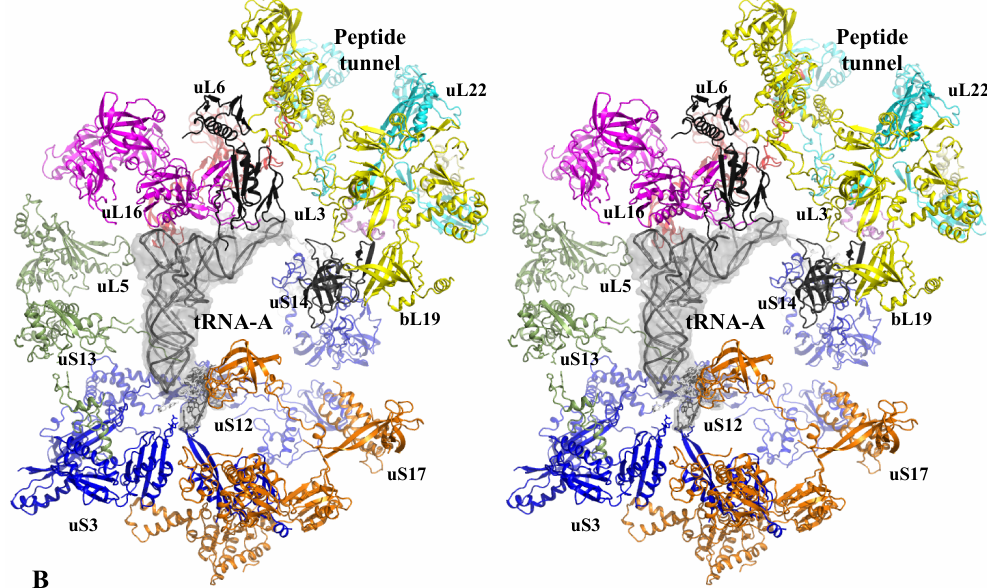
Figure 9. The representation of the bacterial r-protein network. ( A ) A schematic representation of the r-protein nodes (coloured circles), tRNAs (grey squares), mRNA (pale blue line) and the functional centres (coloured ellipsoids) interconnected by black lines that join either the globular domains (circles) or the r-protein extensions (codified by symbols represented in the box). The colours are used to differentiate the functional module or sub-networks. ( B ) Stereoview of the r-proteins and tRNAs in the bacterial ribosome from the A-site tRNA. The modular organisation of r-proteins is shown by colour codes used in ( A ).